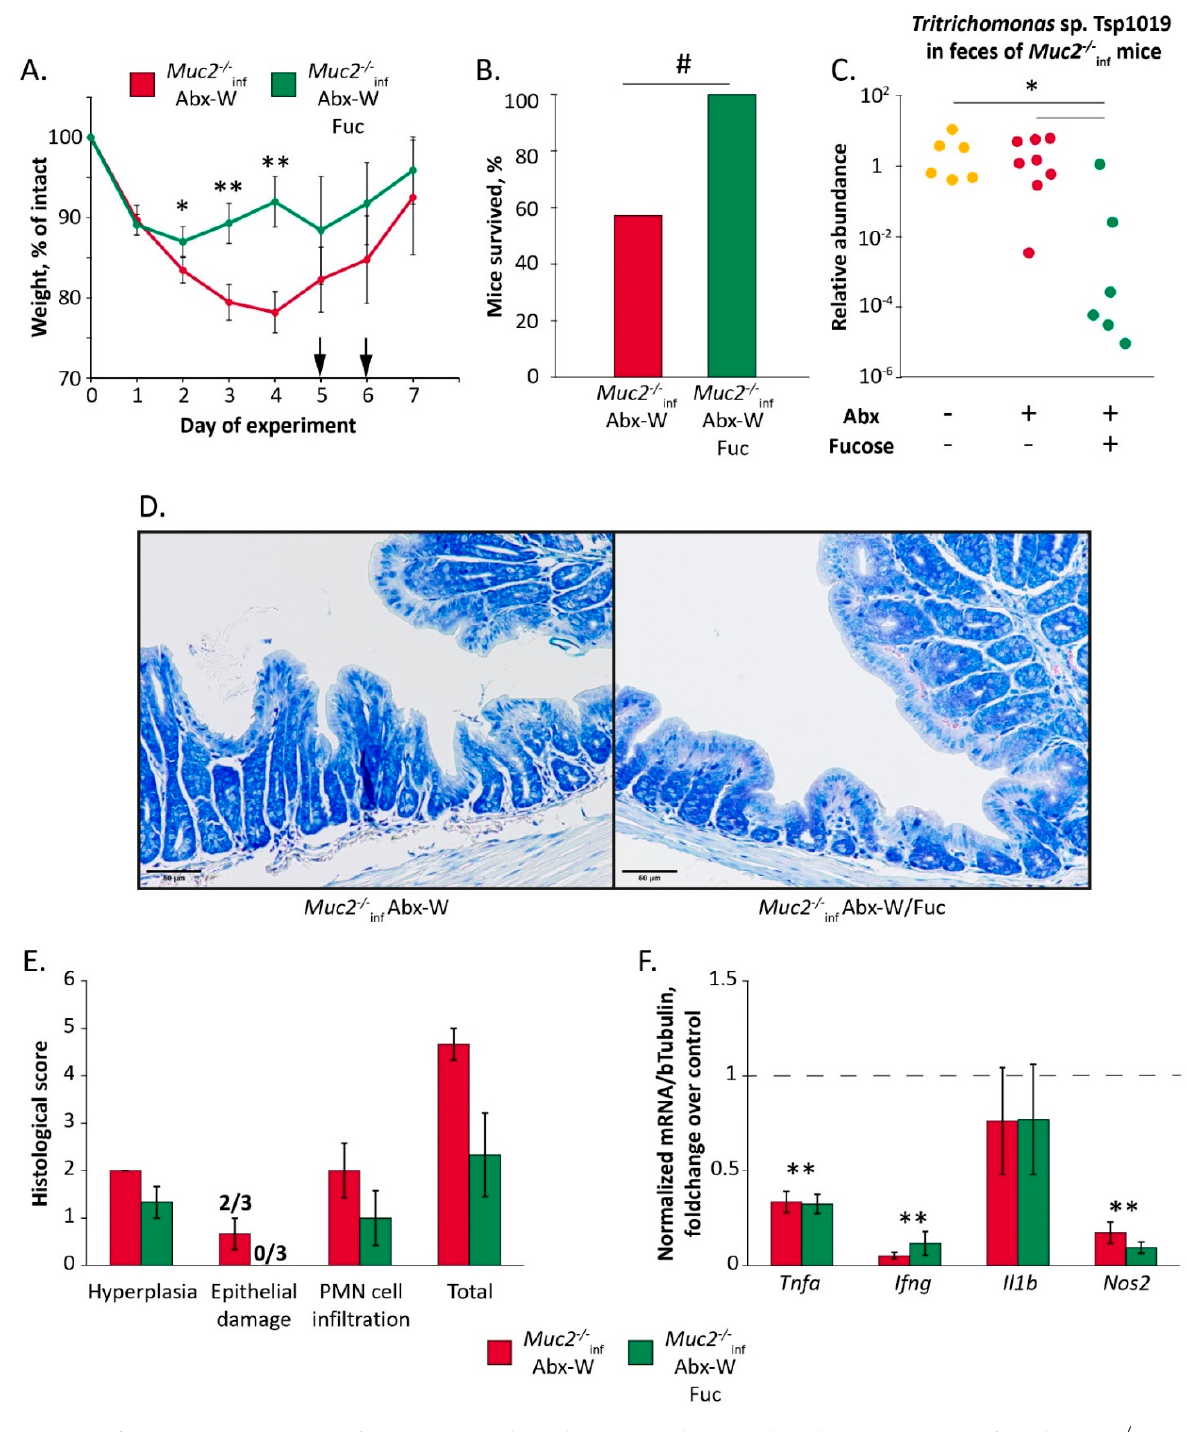
Figure 5. L-fucose suppresses Tritrichomonas sp. and ameliorates antibiotic-induced emaciation in infected Muc2 − / − mice. ( A ) Body weight dynamics upon treatment with antibiotics and L-fucose. *, **— p < 0.05 and p < 0.01, Mann–Whitney u-test. Arrows indicate the days when death was observed. ( B ) Survival rate. #— p < 0.05, Fisher Exact test. ( C ) Relative abundance of Tritrichomonas sp. in feces normalized on Mus musculus 28S rRNA DNA. *—differences between groups p < 0.05, Mann–Whitney u-test. ( D ) Azur-II-eosin-stained colonic sections of Muc2 − / − mice (treated with the antibiotics and control group). Scale bar = 50µm. ( E ) Histological score of inflammation in colon of Muc2 − / − mice. ( F ) Gene expression in colon tissue normalized on beta Tubulin (Tubb5) gene. **—differences compared to mRNA level in control group indicated by dotted line, p < 0.01, Mann–Whitney u-test. Experimental groups: “Abx-W”—treatment with the antibiotics via drinking water for 7 days; “Abx-W/Fuc”—treatment with antibiotics with L-fucose via drinking water for 7 days.